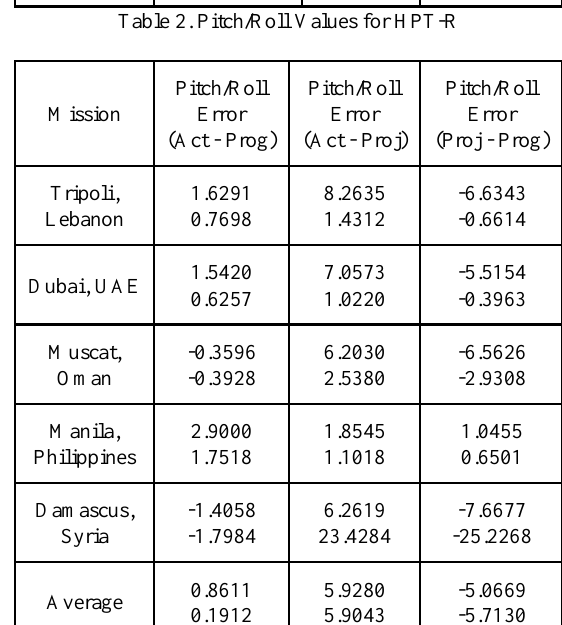
Table 2. Pitch/Roll Values for HPT-R